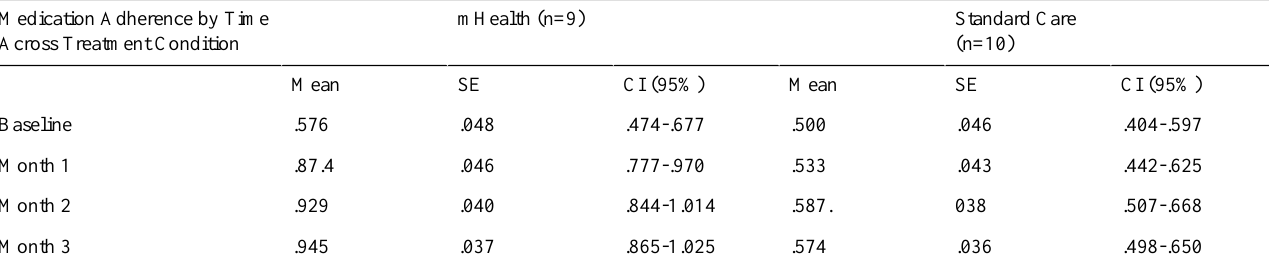
Table 2. Medication adherence by time across treatment condition (Bonferroni adjusted 95% confidence intervals[CI]).